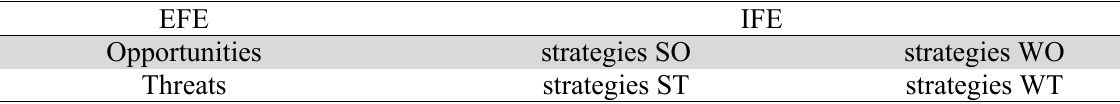
SWOT Matrix (Bamberger & Meshoulam, 2002) EFE IFE Opportunities strategies SO strategies WO Threats strategies ST strategies